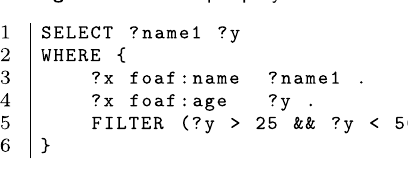
Join each star-shape first and combine all later